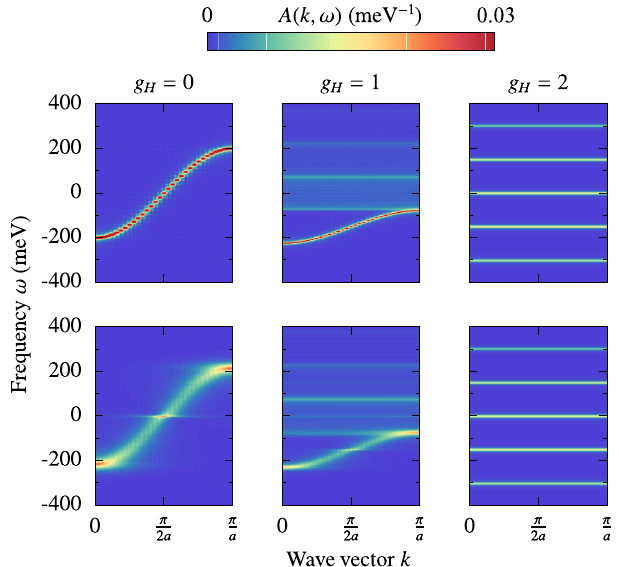
FIG. 1. Momentum-resolved spectral function A ð k; ω Þ at T ¼ 300 K with no dynamic disorder (top row) and strong 2 , bottom row) at different values of dynamic disorder ( g P ¼ Holstein coupling g . Calculated with electronic transfer integral H τ ¼ 100 meV, phonon frequencies ω 6 meV and ω P ¼ H ¼ 150 meV, and a Lorentzian broadening with η ¼ 2 . 5